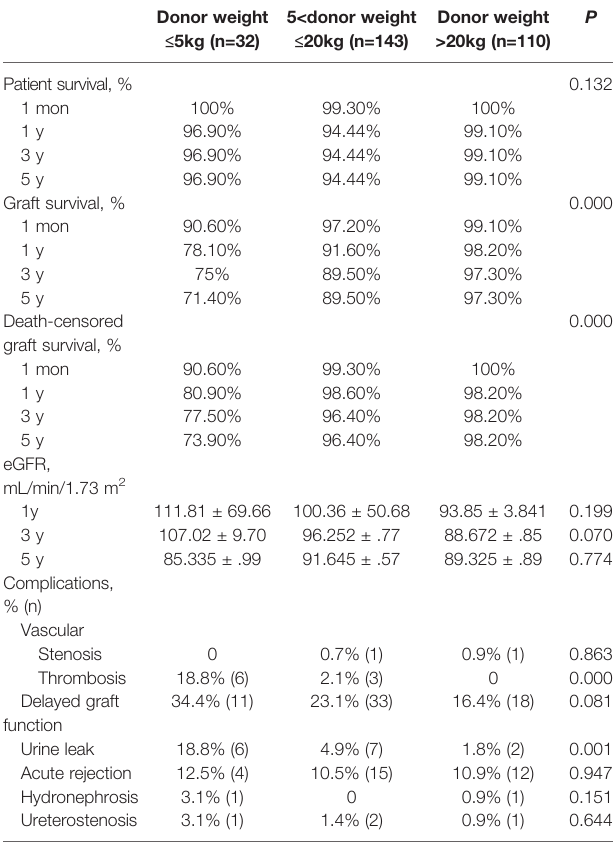
TABLE 2 | Comparison of kidney transplantation outcomes.